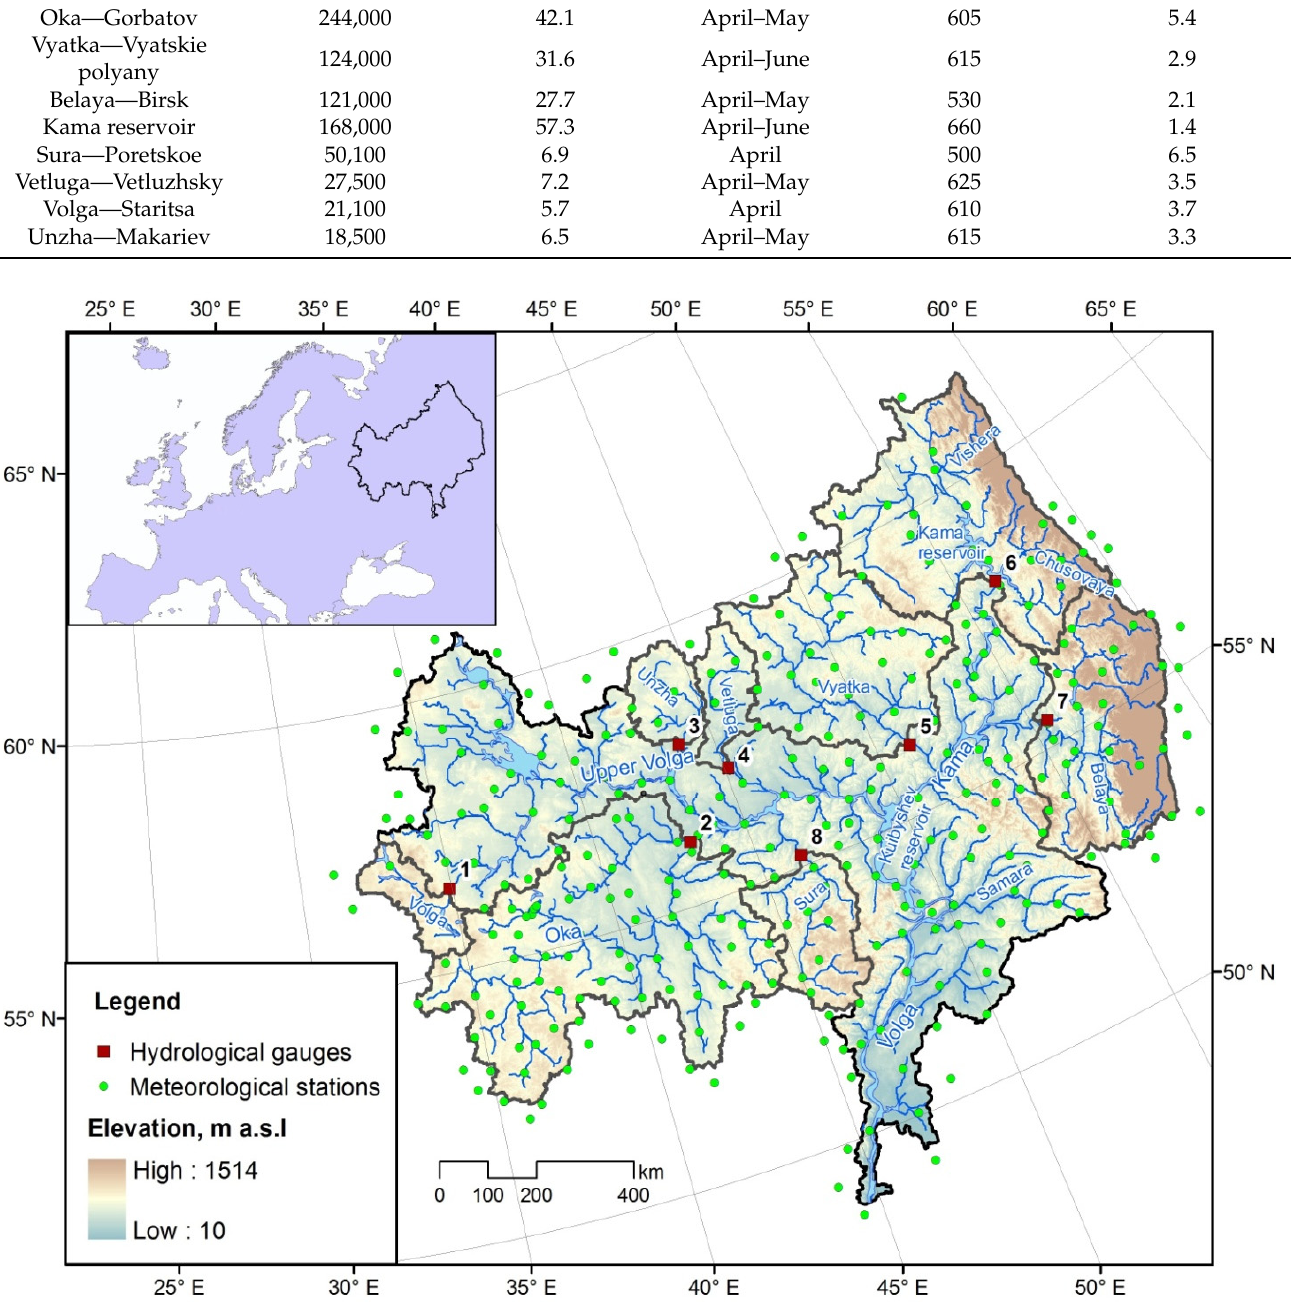
Figure 1. The Volga basin and main rivers whose flow data were used to test the hydrological model: 1—Upper Volga; 2—Oka; 3—Unzha; 4—Vetluga; 5—Vyatka; 6—Kama Reservoir; 7—Belaya;